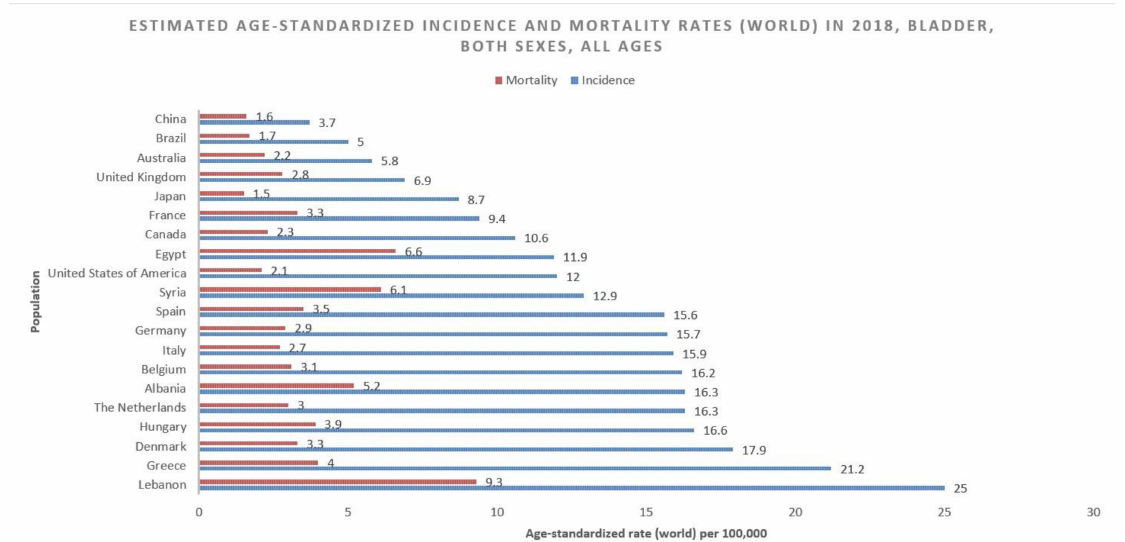
Figure 1. Bar chart showing estimated age-standardized incidence and mortality rates (world) in 2018, bladder cancer, all sexes, all ages. Data obtained from Globocan 2018 [2].